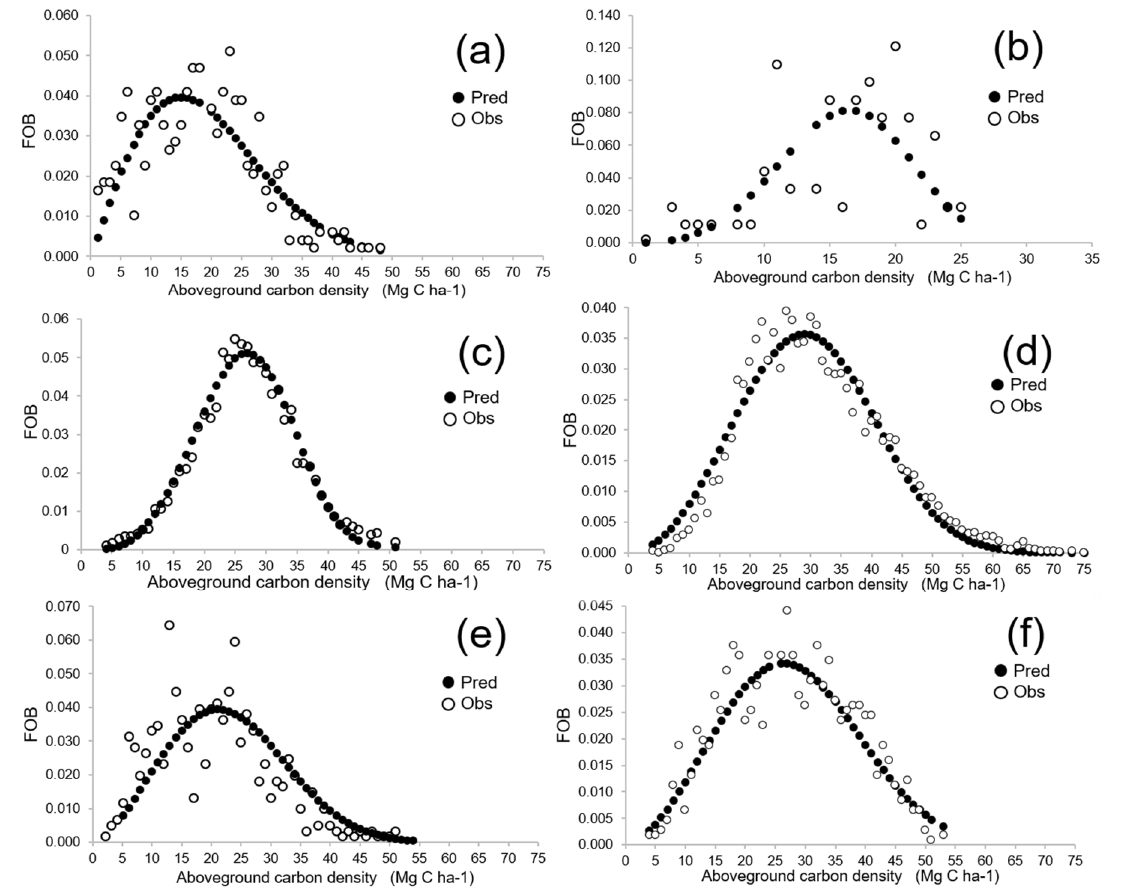
Figure 2. Predicted and observed fire occurrence by biomass level (FOB) against aboveground carbon density (AGCD) (Mg C ha −1 ) for each region CHAP ( a ); N ( b ); NW and NE ( c ); C ( d ); SC ( e ) density (AGCD) (Mg C ha − 1 ) for each region CHAP ( a ); N ( b ); NW and NE ( c ); C ( d ); SC ( e ) and SE ( f ); and SE ( f ); Pred: Predicted values; Obs: Observed values. Pred: Predicted values; Obs: Observed